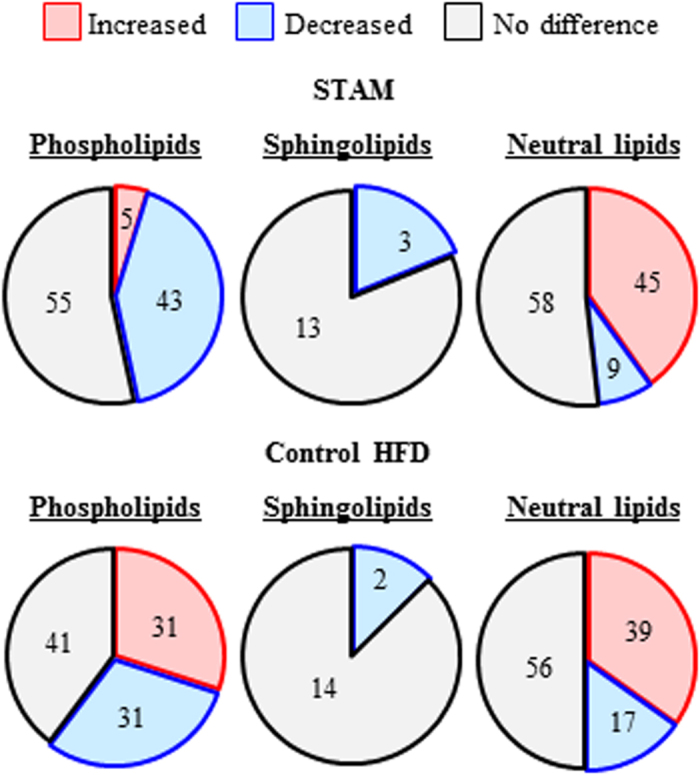
Venn diagrams of the number of phospholipids, sphingolipids and neutral lipid molecules that were statistically significantly different in abundance between STAM (upper panel) and HFD (lower panel) mice at 8 and 12 weeks.Increased: 12 weeks > 8 weeks, decreased; 12 weeks < 8 weeks.